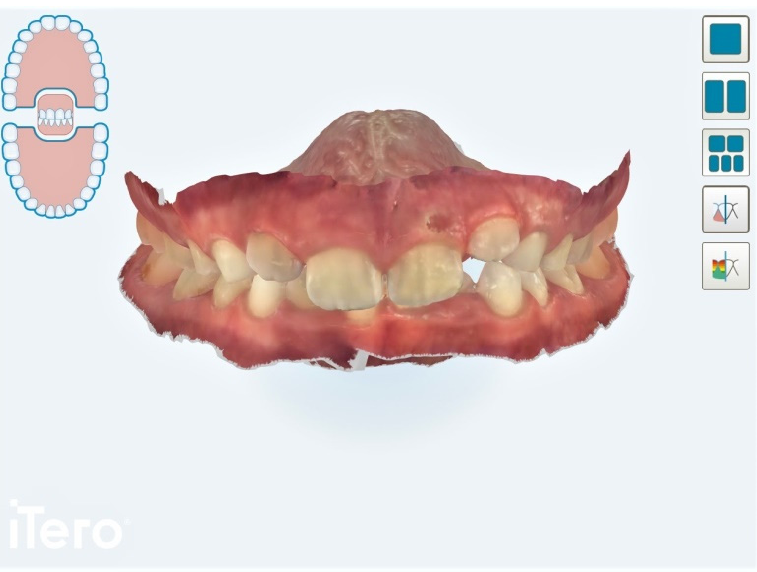
Figure 1. Images obtained immediately after performing a digital intraoral scan [Own source]. With the use of OrthoCAD, the following were measured: Dimension A—the anterior width of the upper dental arch—the distance between the cusps of the permanent or deciduous upper canines (Figure 2); Dimension B—posterior width of the upper dental arch, measured between the central grooves at the gingival margin of the first permanent upper molars (Figure 2); Dimension C—the anterior width of the lower dental arch—the distance between the cusps of the permanent or deciduous lower canines (Figure 2); Dimension D—the posterior width of the lower dental arch, measured between the buccal cusps of the first permanent molars, from the point of the highest convexity of one tooth to the point of the highest convexity of the other tooth on the opposite side (Figure 2). The changes in parameters A and B were calculated as the difference between the values measured before treatment (measurement 1) and after a 10 month period (measure- men